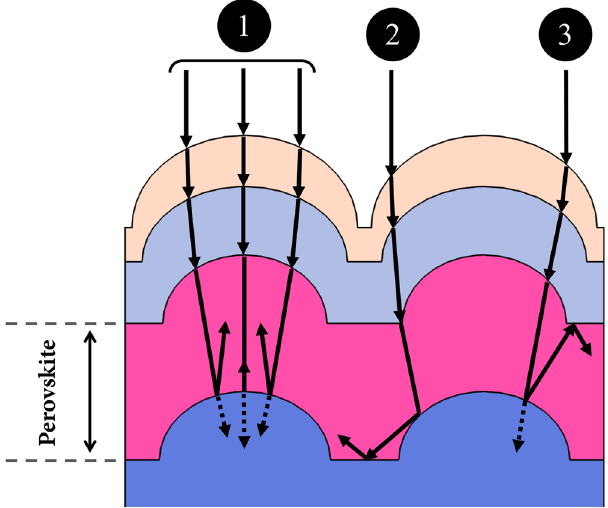
Fig. 5. Schematic of the light-trapping principle in the convex nanostructured